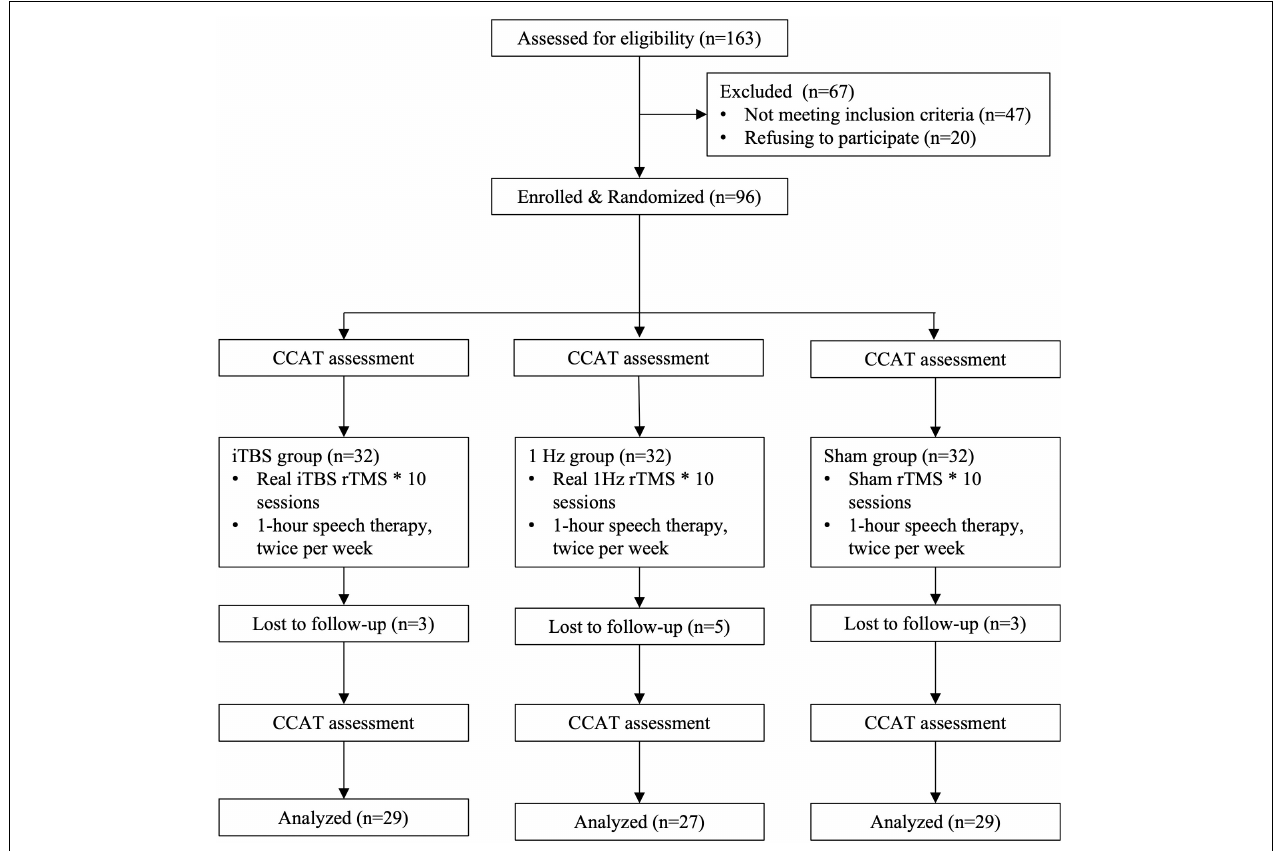
FIGURE 1 | Flowchart for recruitment, group allocation, treatment allocation, follow-up, and